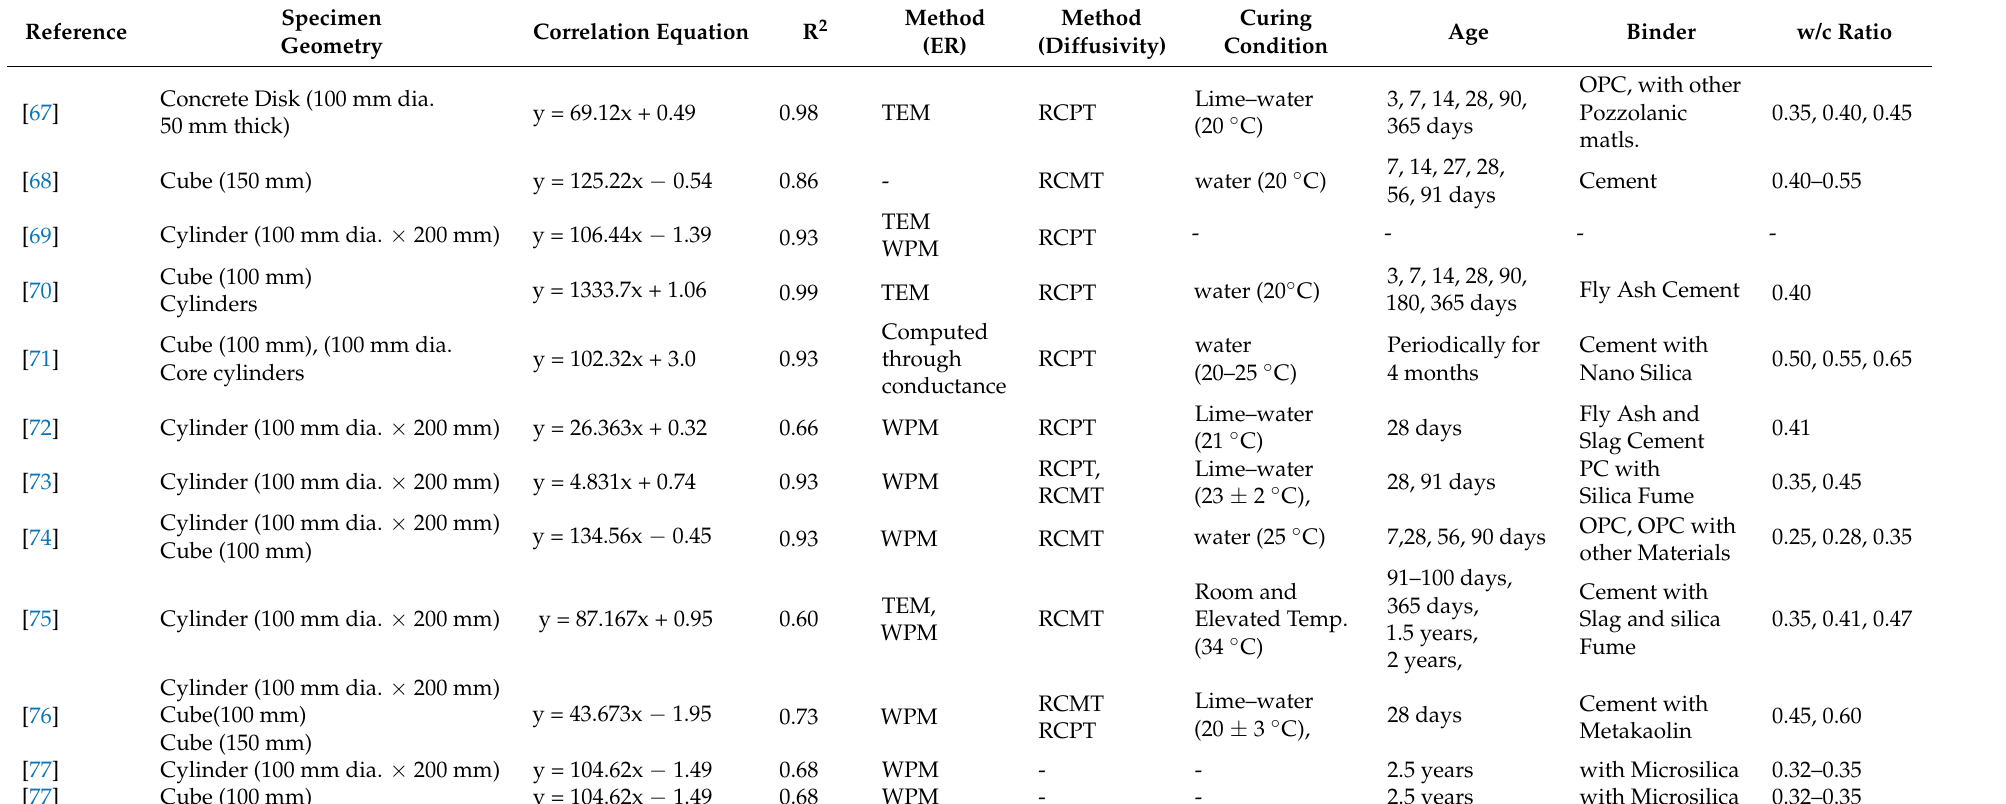
Table 1. Details of specimens used from different references for the correlation of electrical resistivity and chloride diffusivity, including the specimen geometry, regression equation, measurement method, curing condition, age, type of binder, and water-to-cement (w/c)